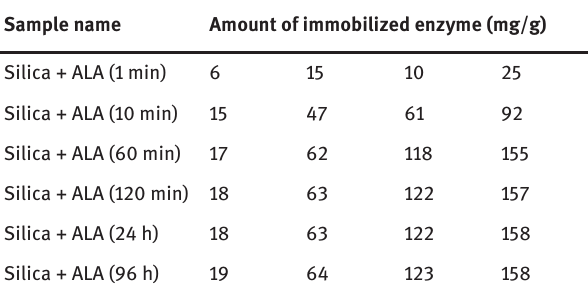
Table 3: Amounts of immobilized